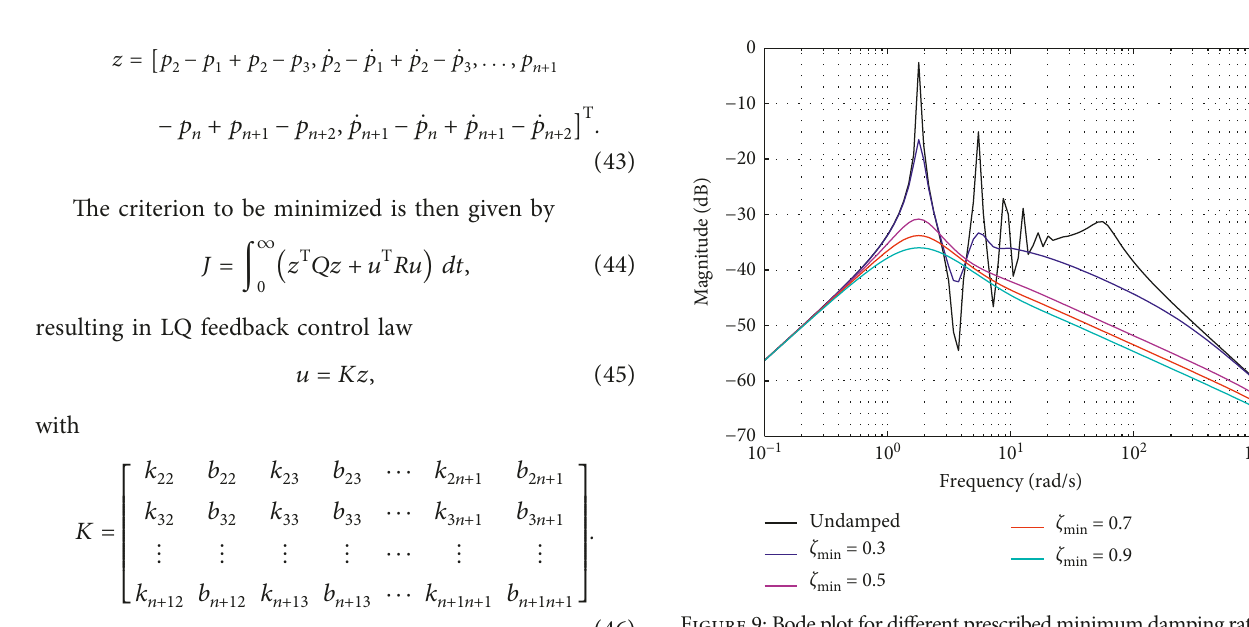
Figure 9: Bode plot for different prescribed minimum damping